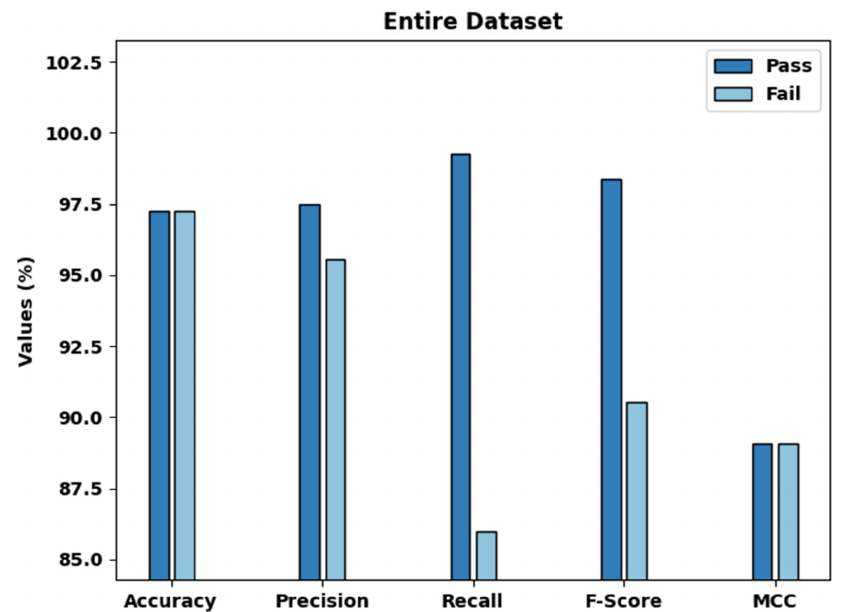
Figure 4. Result analysis of FSSML-EDM technique on entire dataset.